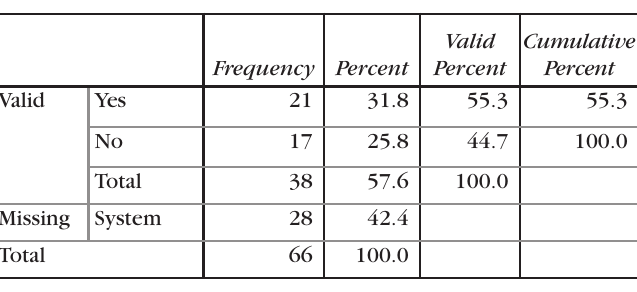
Table 6. Growth Factor Frequencies